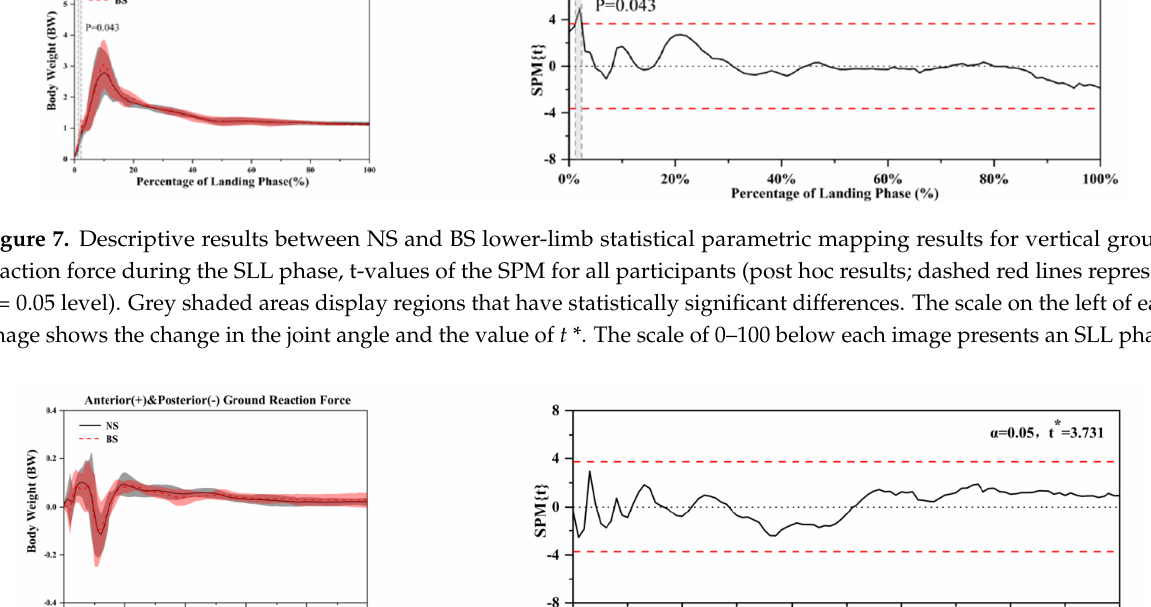
Figure 8. Descriptive results between NS and BS lower-limb statistical parametric mapping results for anterior and posterior ground reaction force during the SLL phase, t -values of the SPM for all participants (post hoc results; dashed red lines represent p = 0.05 level). The scale on the left of each image shows the change in the joint angle and the value of t *. The scale of 0–100 below each image presents an SLL phase.